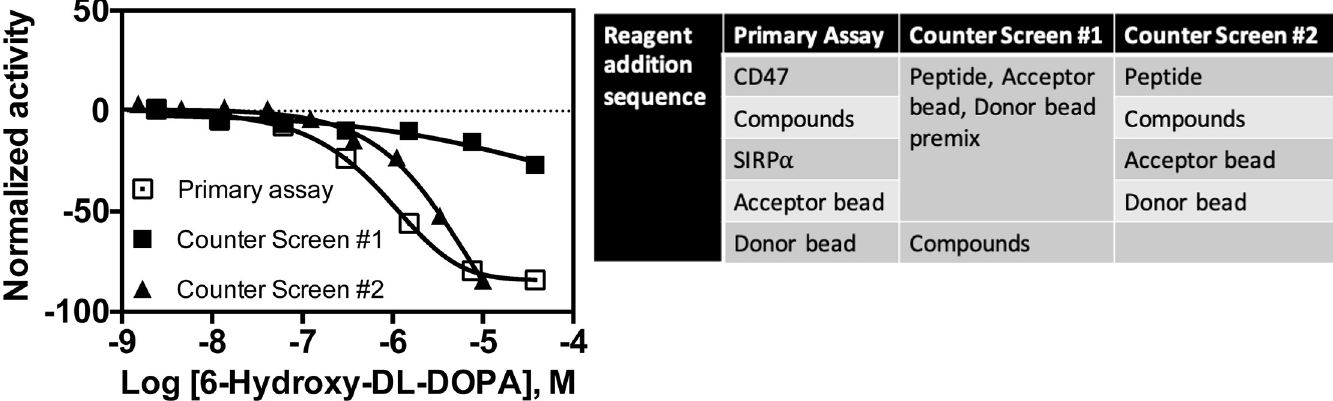
Fig 13. Comparison of 6-Hydroxy-DL-DOPA AlphaScreen. Activity shown using the CD47-SIRP α PPI assay (left panel) and the counter screen assay run under different reagent addition sequences (right panel).